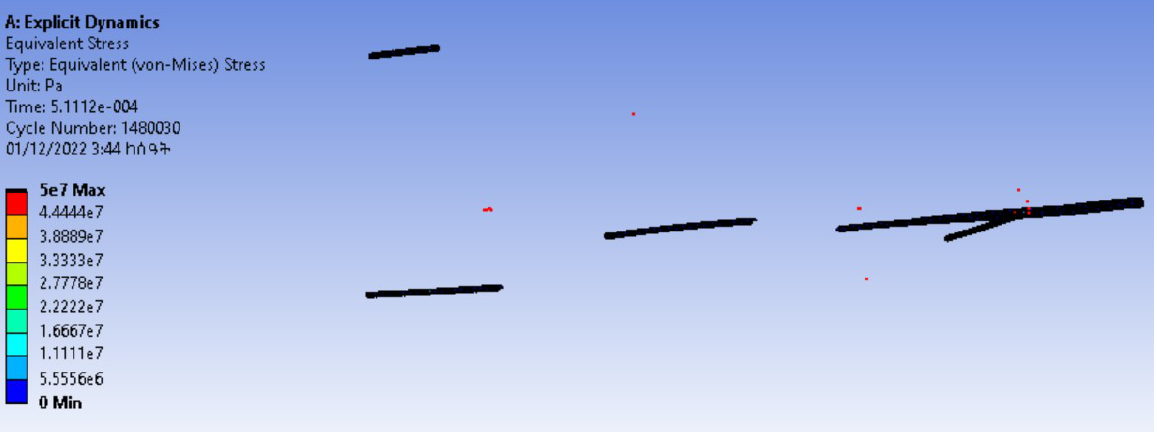
Figure 22. Simulation of the tensile test at element sizes less than or equal to 4